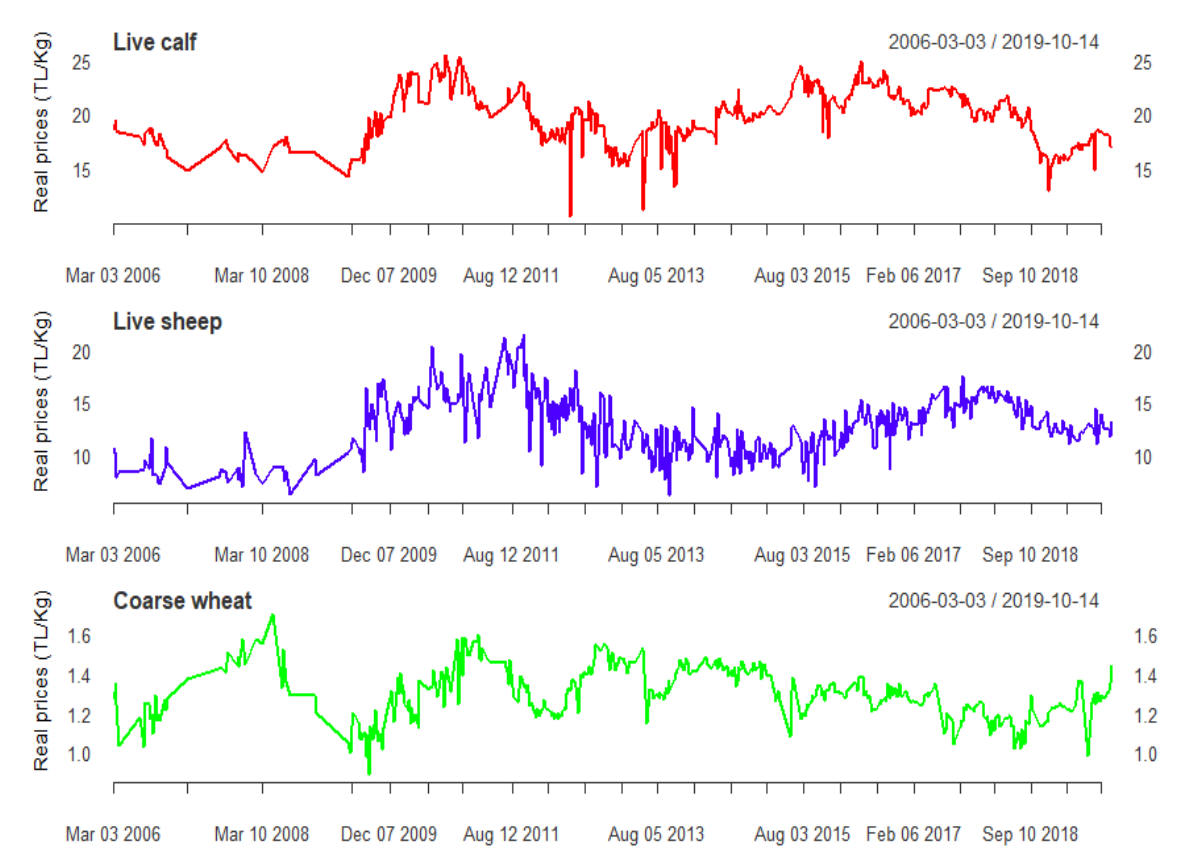
Figure 1. Daily real prices of live calves, live sheep, and coarse wheat.